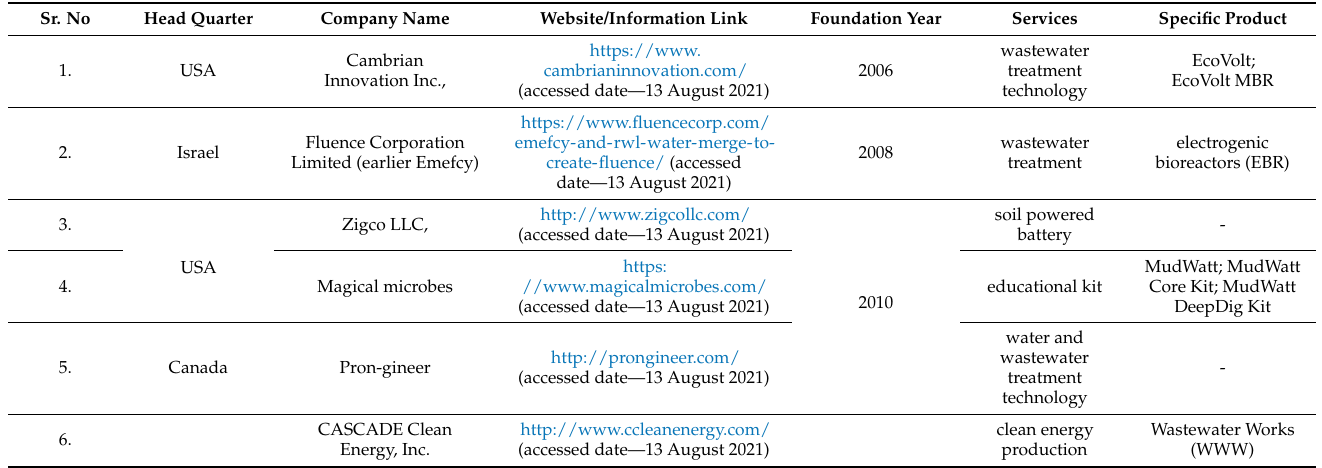
Table 5. Various MFC commercialization.